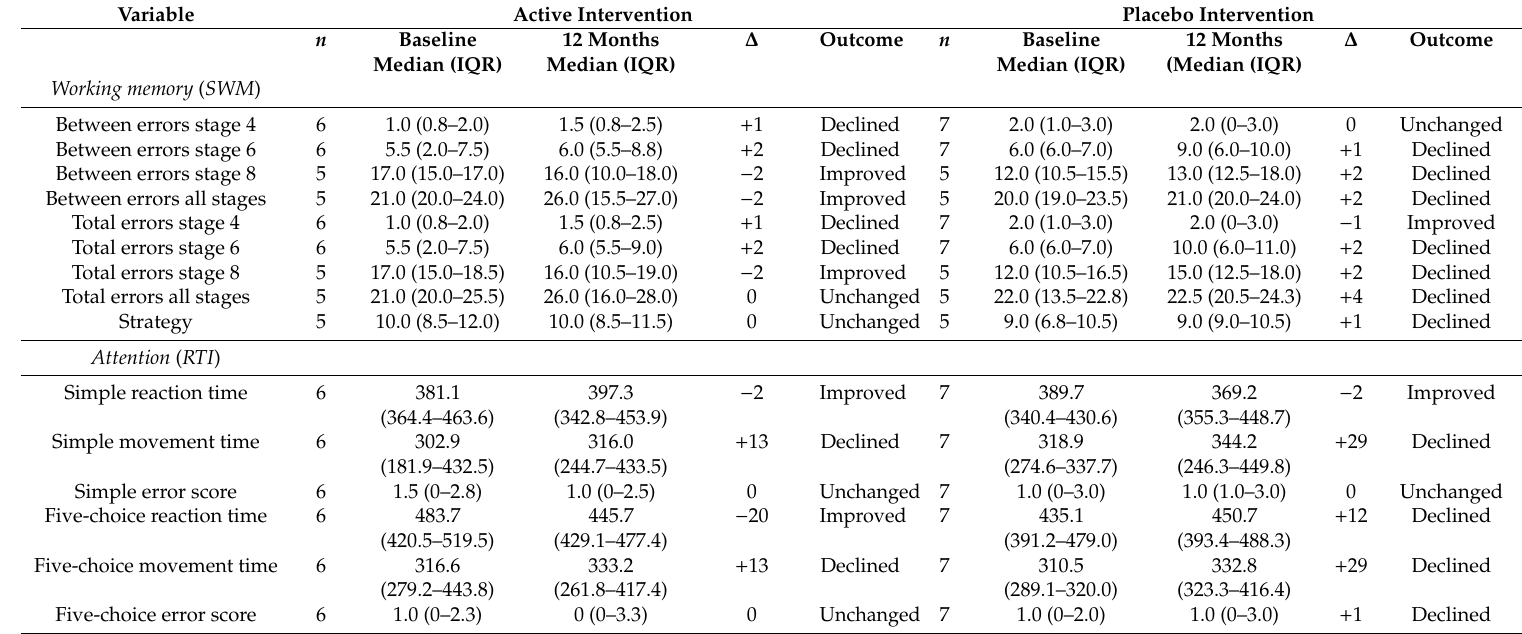
Table 7. Average change per subject in working memory and reaction time over 12 months between active and placebo intervention